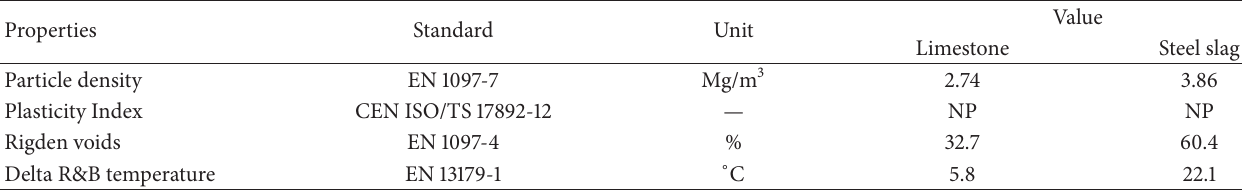
Table 2: Basic properties of the studied